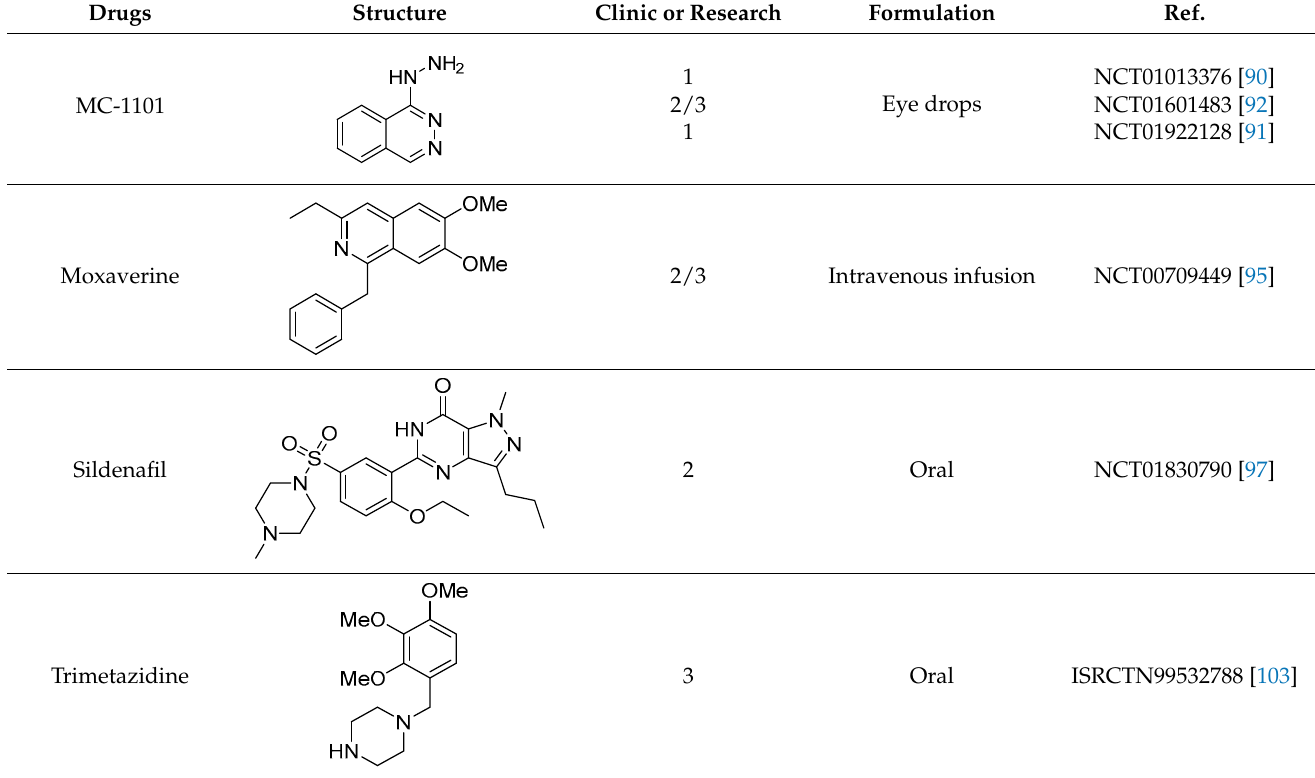
Table 3. Drugs targeting choriocapillaris atrophy.